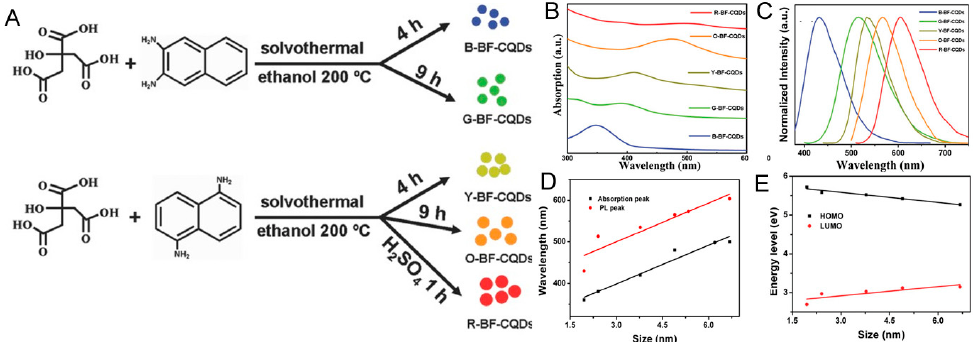
Figure 3. Different hypotheses for carbon dot (CD) emission mechanism: reprinted with permis- sion from [64], copyright 2019 Springer